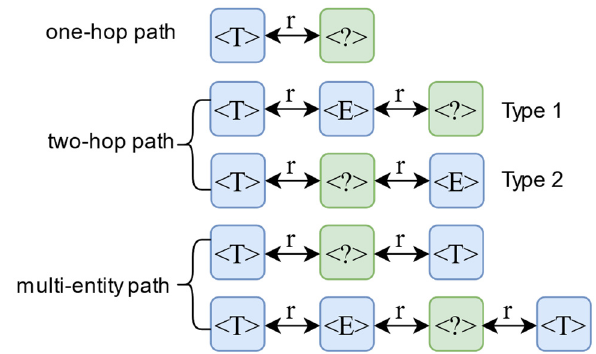
Figure 2. The types of candidate path templates.